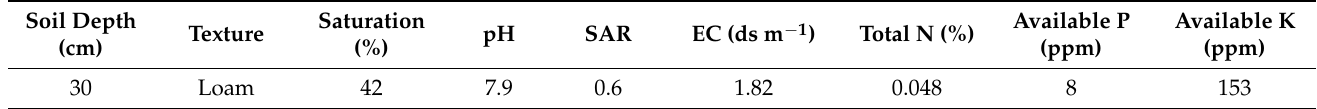
Table 1. Soil status of a citrus orchard at the study location in Punjab, Pakistan.